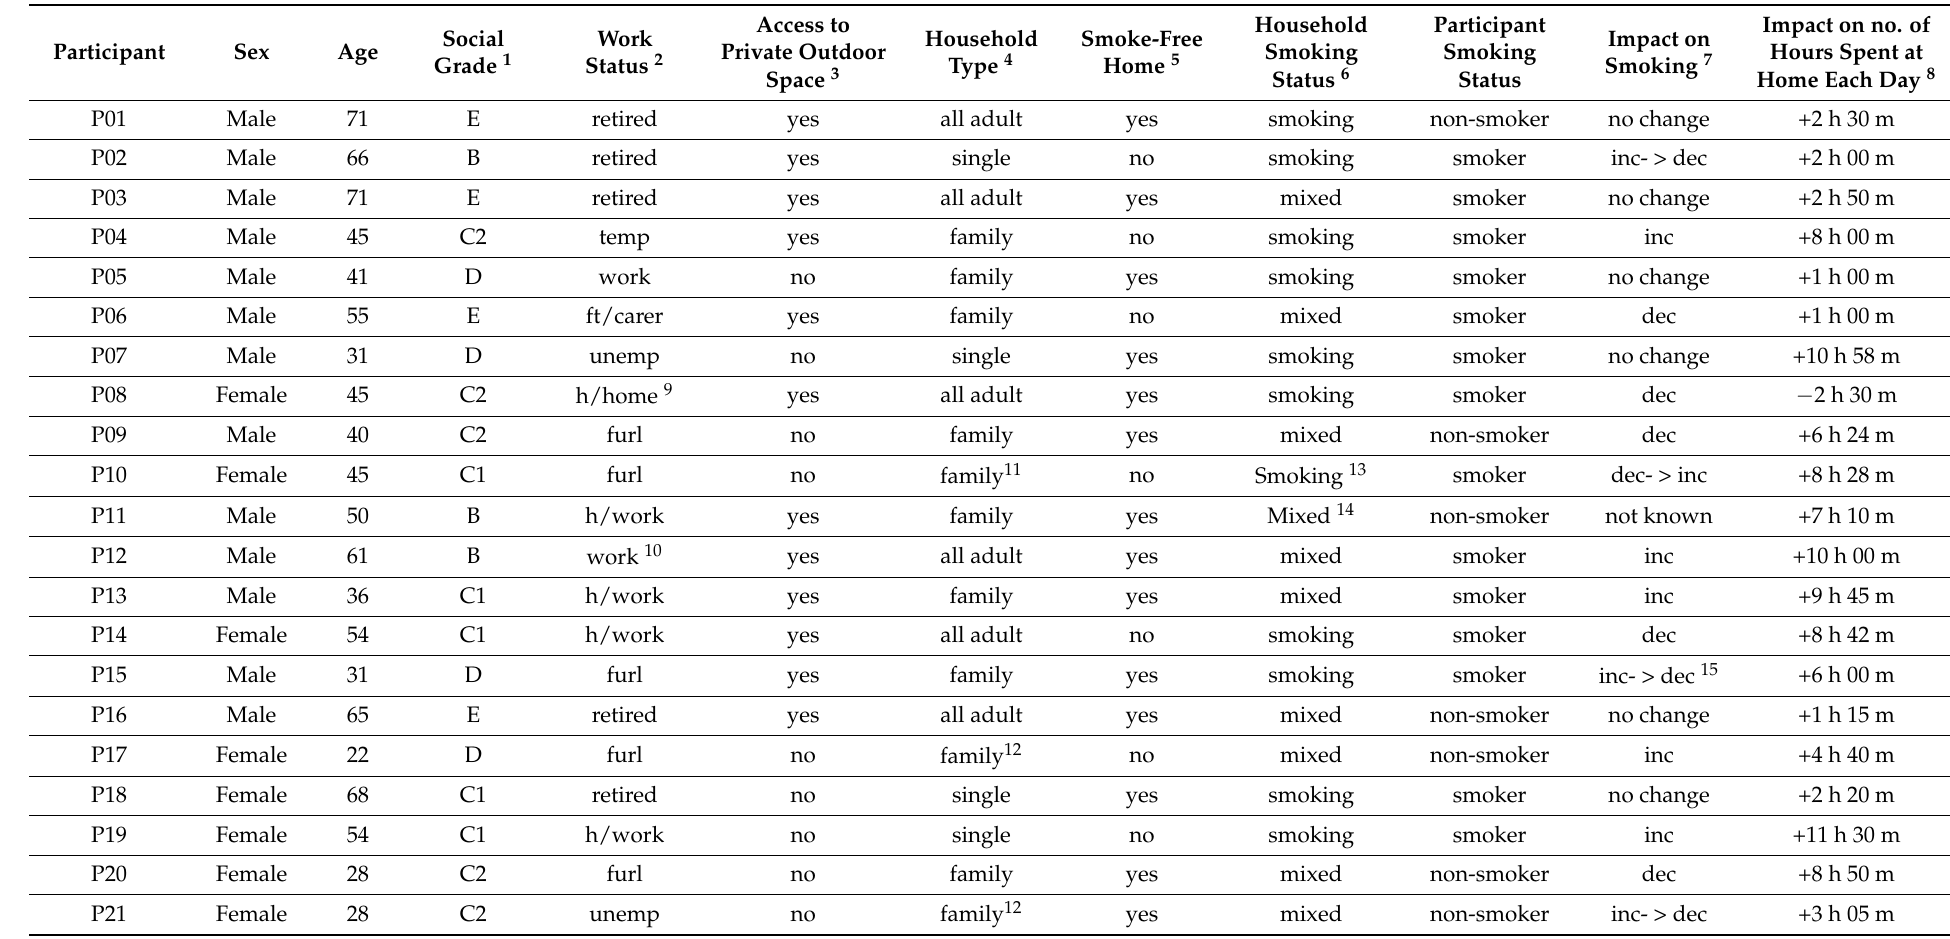
Table 1. Participant characteristics (n =